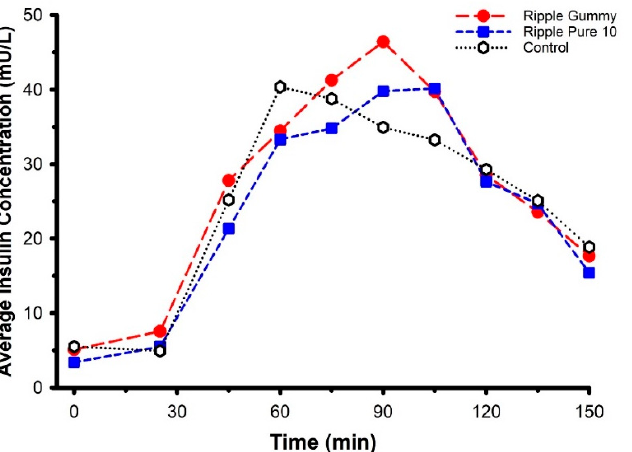
Figure 6. Mean circulating insulin concentrations following ingestion of two commercially available edible marijuana (10 mg of THC) and one marijuana-free control product. Seventy-five grams of glucose was ingested at 30-min. There were no differences in circulating insulin between products (product × time interaction p = 0.74). Error bars have been omitted for clarity.